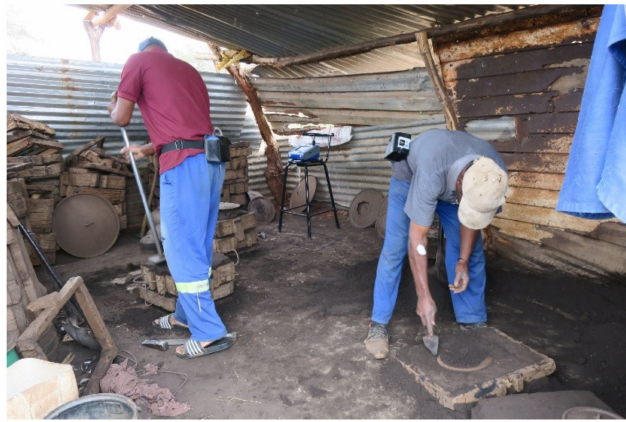
Figure 1. One of the hand-made cookware operation sites with artisans preparing sand